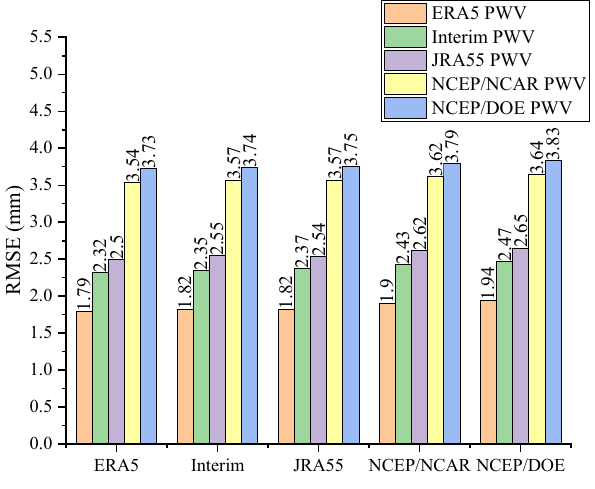
Figure 1. Root mean square error (RMSE) values for ERA5, ERA-Interim, JRA-55, NCEP / NCAR, and NCEP / DOE reanalysis water vapor products relative to Global Navigation Satellite Systems (GNSS) PWV derived from Zenith Tropospheric Delay (ZTD) of Bernese and Zenith Hydrostatic Delay (ZHD) of di ff erent pressure values of ERA5, ERA-Interim, JRA-55, NCEP / NCAR, and NCEP / DOE reanalysis pressure products around the world (source: own elaboration).